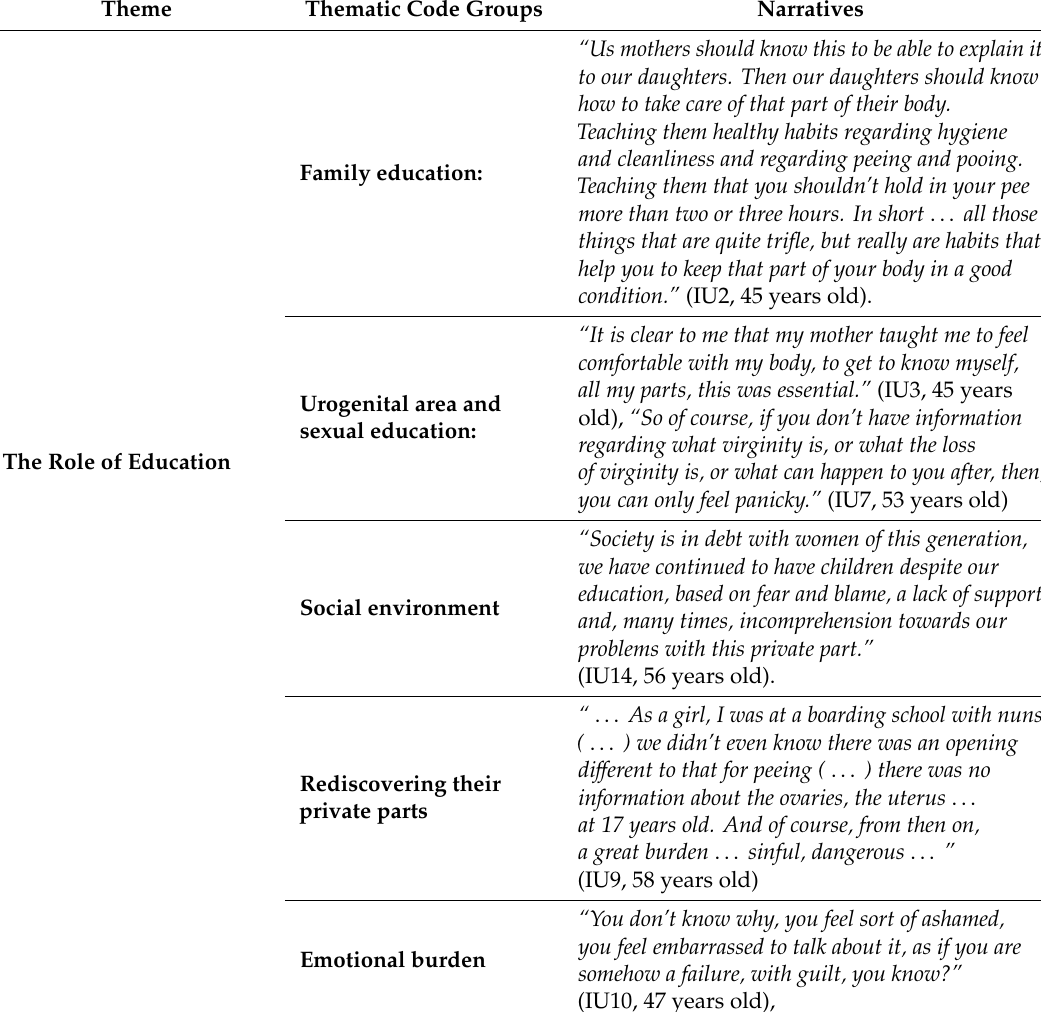
Table 6. Participants’ narratives from the theme: The Role of